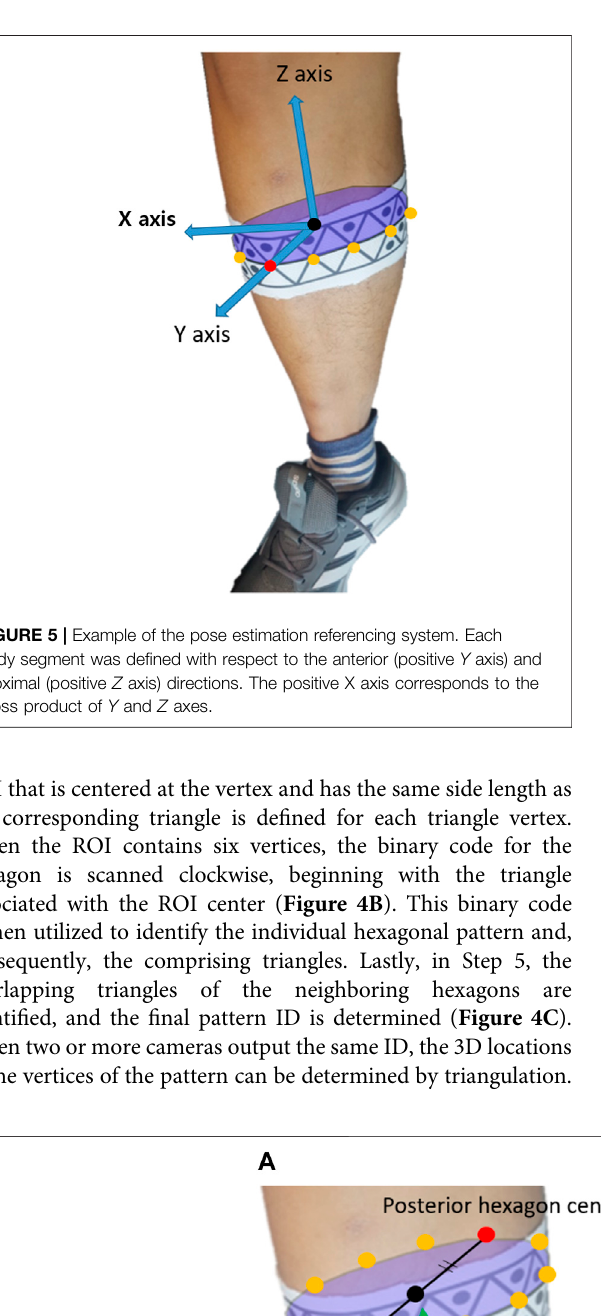
FIGURE6| Illustrativeexampleofhowtheposeestimationreferencingsystemwasutilizedtodeterminethegeometricparameters ofabodysegment.Inthestatic step,thegeometricparametersofeachbodysegmentarecollected.Asshownin (A) ,thepositive Y axiscorresponded totheanteriordirectionofbodysegments;itwas de fi ned asthe vector extending from the center of the posterior hexagon to the center of the anterior hexagon. These centers were prede fi ned as the respective centers of the anterior and posterior points of each body segment and were thus positioned as such. The origin was de fi ned as the midpoint between the centers of the posteriorandanteriorhexagons.Asshownin (B) ,thedistancebetweentheoriginandeachvertexofeach marker(i.e.,notonlythehexagoncenters)wasdenotedas r n . Additionally, the angles between the positive Y axis and the vectors for each hexagon center were determined ( θ n ). r n and θ n were utilized in the motion-analysis step to reconstruct the positive Y axis and origin when the anterior and posterior hexagons could not be recognized.